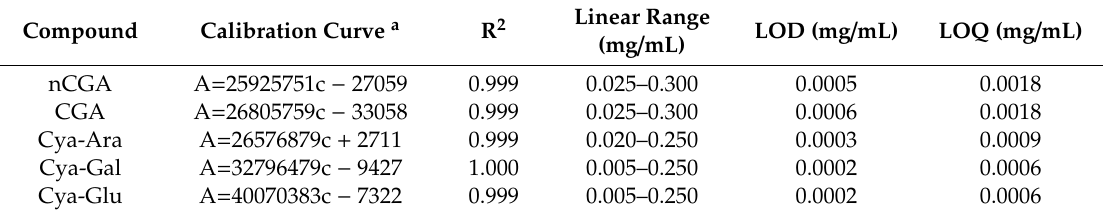
Table 4. Calibration curves, concentration range, limit of detection (LOD), and limit of quantification (LOQ) for